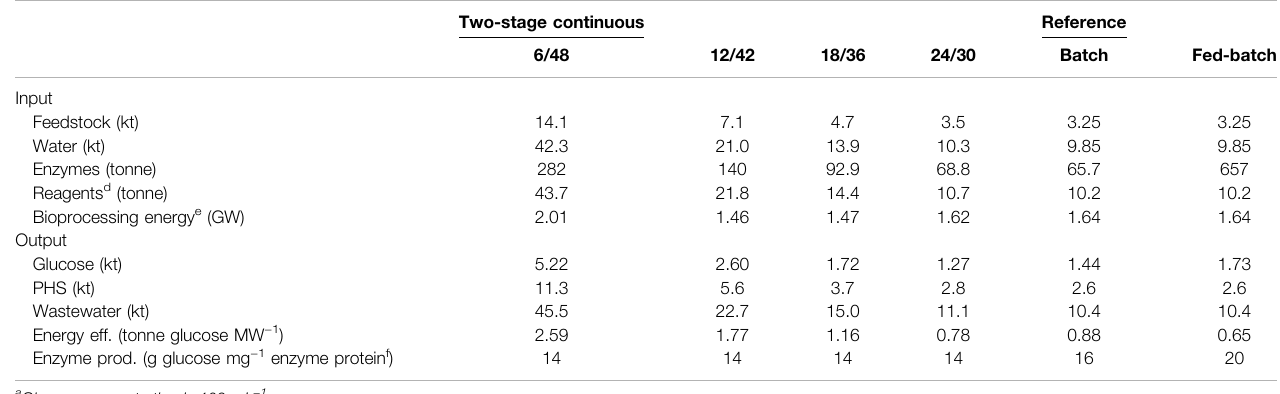
TABLE 4 | Summary of M&E balances of the demonstration-scale con fi gurations.